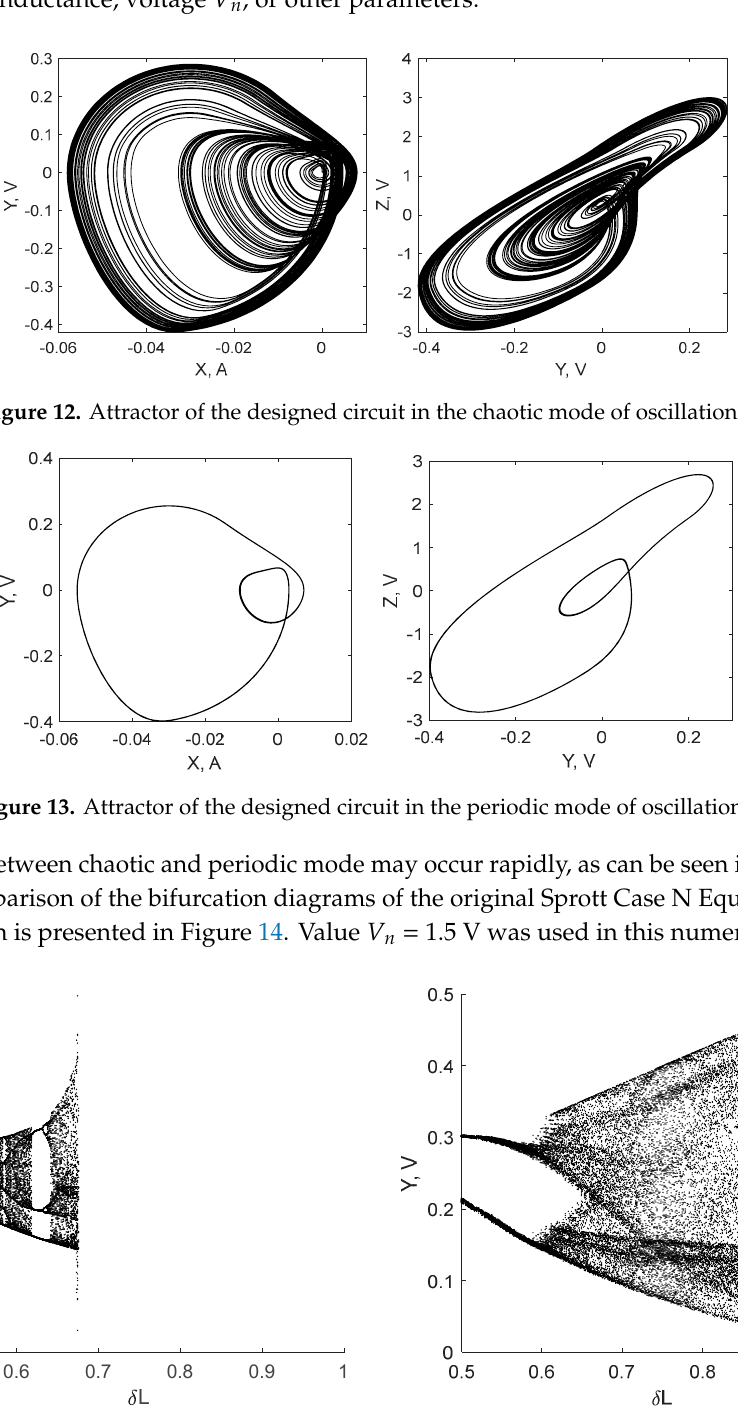
Figure 11. Bifurcation diagram of the chaotic circuit based on the Sprott Case N chaotic oscillator. When the inductance L changes from 0.5 to 1 of its nominal value, the system regime changes from periodic to chaotic oscillations through period doubling.